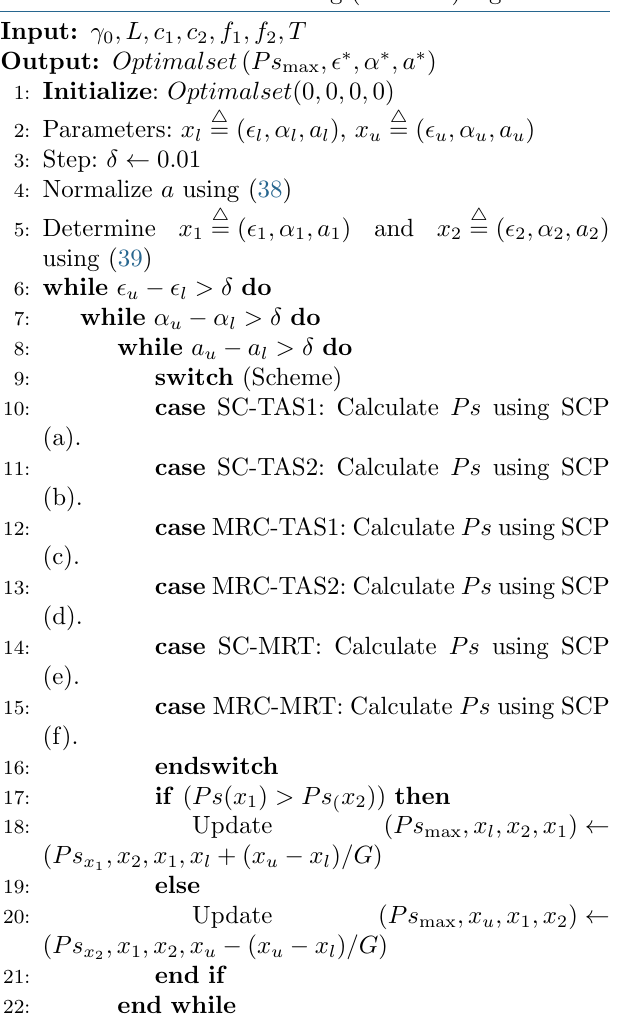
Algorithm 3 Successful computation probability maximization Golden searching (SCPMG)